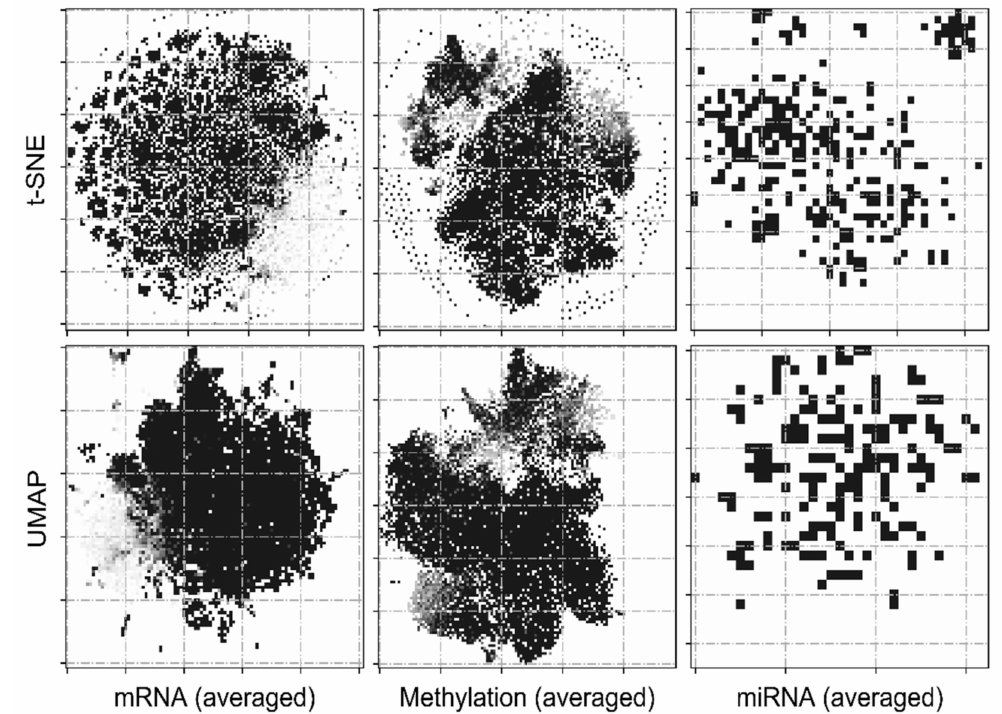
Figure 2. Graphical representations of omics datasets generated via t-SNE and UMAP. Every pixel in the image can be attributed to a gene, while its intensity quantifies the corresponding expression